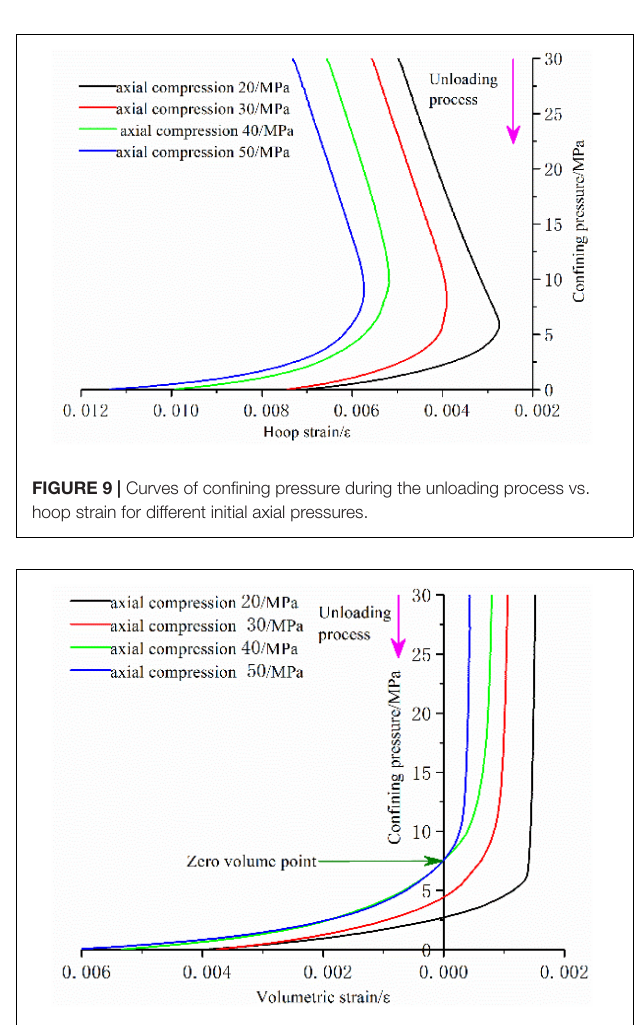
FIGURE 10 | Curves of confining pressure during the unloading process vs. volumetric strain for different initial axial pressures.